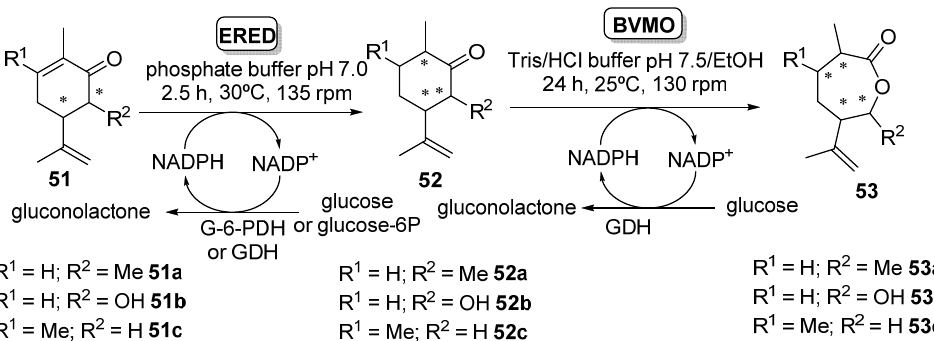
Scheme 20. Enzymatic sequential conversion of synthetic analogues of carvones 51 into dihydrocarvones 52 and carvolactones 53 .